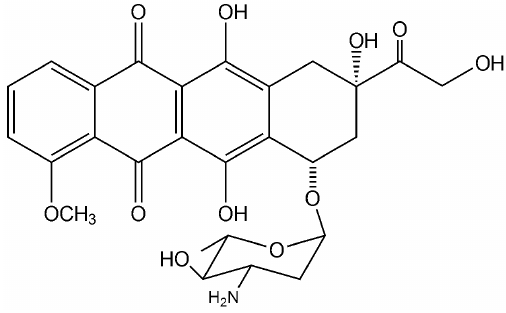
Figure 1. Chemical structure of epirubicin.